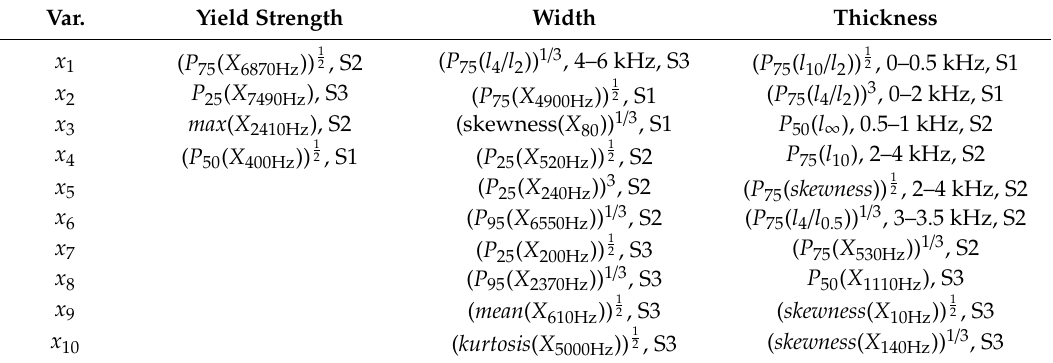
the sensors no. 1, 2, and 3,